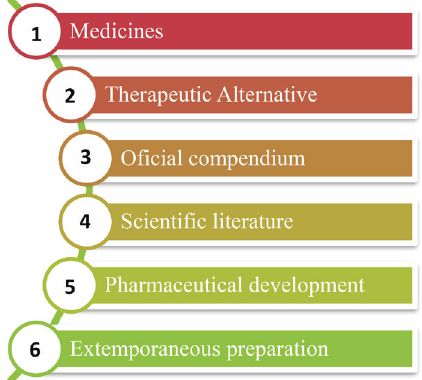
FIGURE 1 - Situational analysis to the preparation of extemporaneous oral liquid (Glass, Haywo,